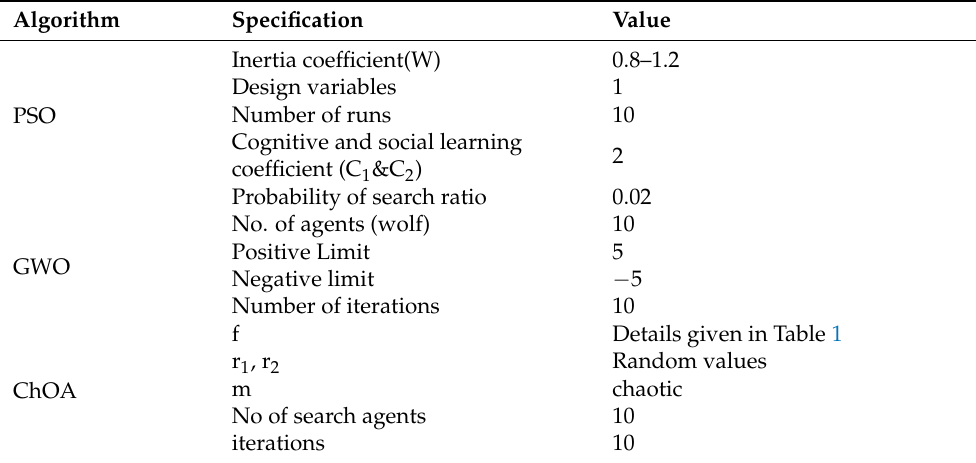
Table 5. Tuning parameters of benchmark algorithm.